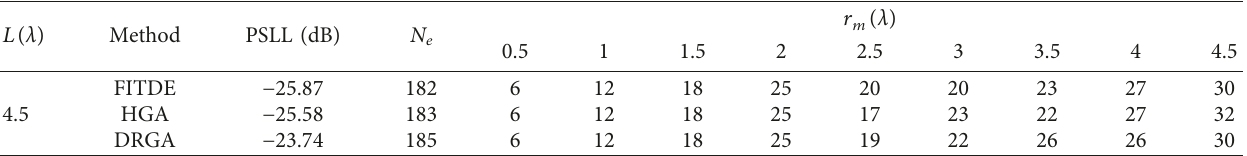
Figure 8: Result of Example 2. (a) PSLL of 50 independent runs in Example 2. The best PSLL is − 25.87dB, the average PSLL is − 25.73dB, and the variance is 0.014. (b) is the best radiation pattern of all planes, characteristic of excellent symmetry. (c) is the sectional pattern of one single plane. (d) is the optimal distribution of elements. Table 6: Results of Example